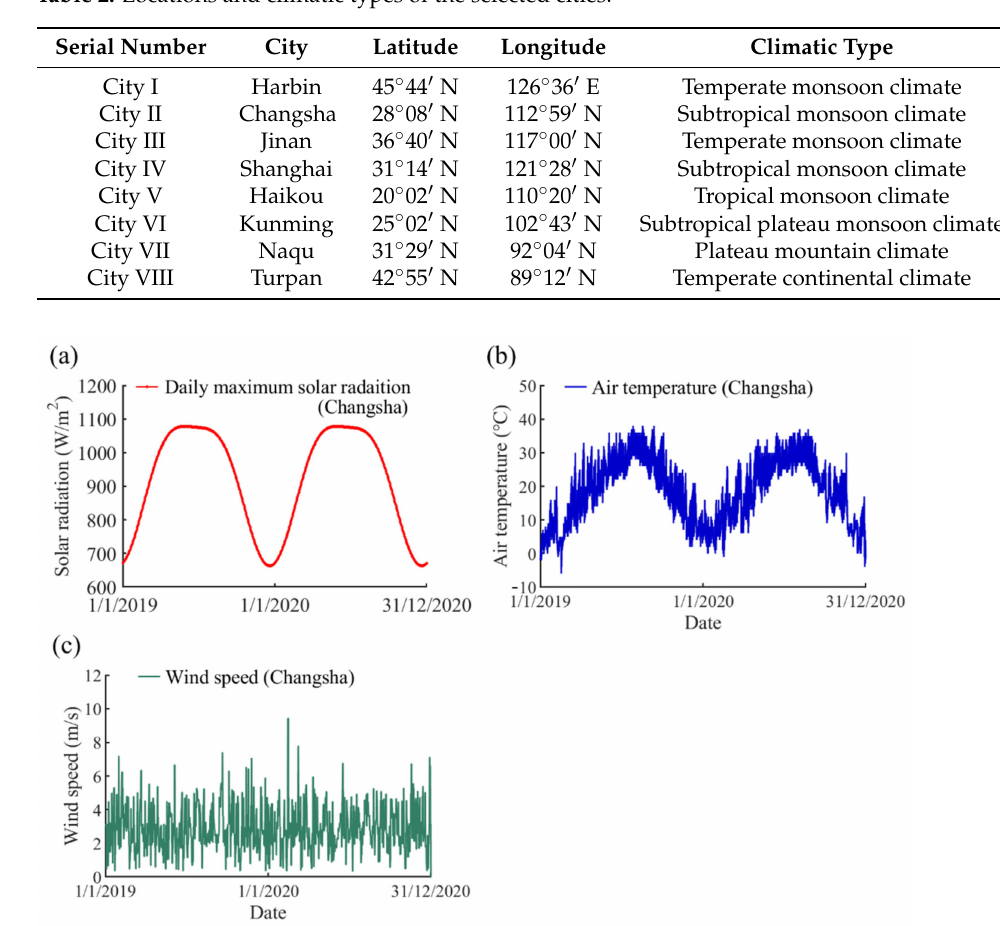
Figure 13. The long-term climatic parameter variation in Changsha: ( a ) daily maximum solar radiation; ( b ) air temperature; and ( c ) wind